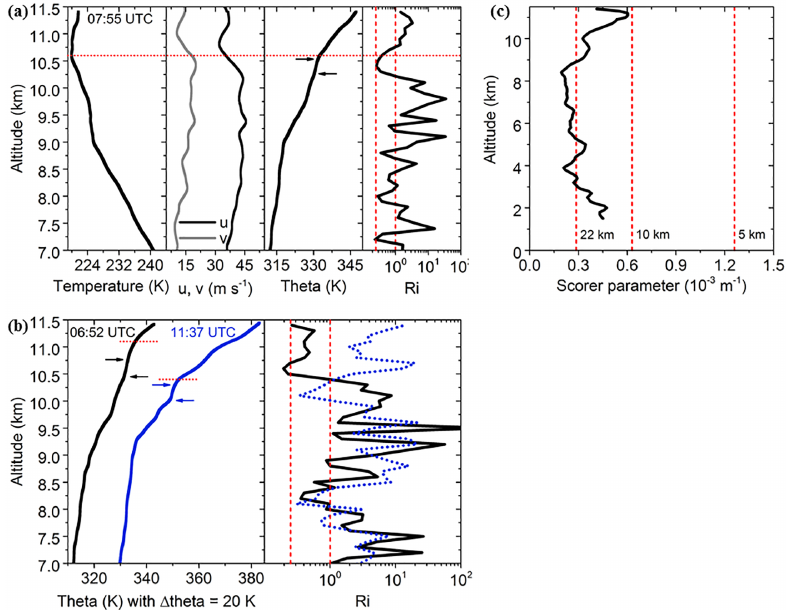
Figure 7. Dropsonde launches from 12.2km height during the GV flight RF16. The panels in (a) represent the profiles of temperature, poten- tial temperature, horizontal wind components and Richardson number for GPS altitudes from 7.0 to 11.5km for a dropsonde at 07:55UTC. The lower panel (b) shows the profiles of potential temperature and Richardson number for dropsondes launched at the same location as the dropsonde from (a) at 06:52UTC (black) and 11:37UTC (blue). The red dashed lines in the right panel show critical Ri at 0.25 and 1.0, the arrows in the theta panel denote regions with suggested turbulence. Horizontal red dotted lines in (a) and (b) mark the height of the thermal tropopause. (c) Vertical profile of the Scorer parameter (cid:96) (smoothed with a running average) derived from the dropsonde at 07:55UTC (see panel a ). The red dashed lines show vertical profiles of the critical horizontal wavelengths 2 π/(cid:96) of 5, 10 and